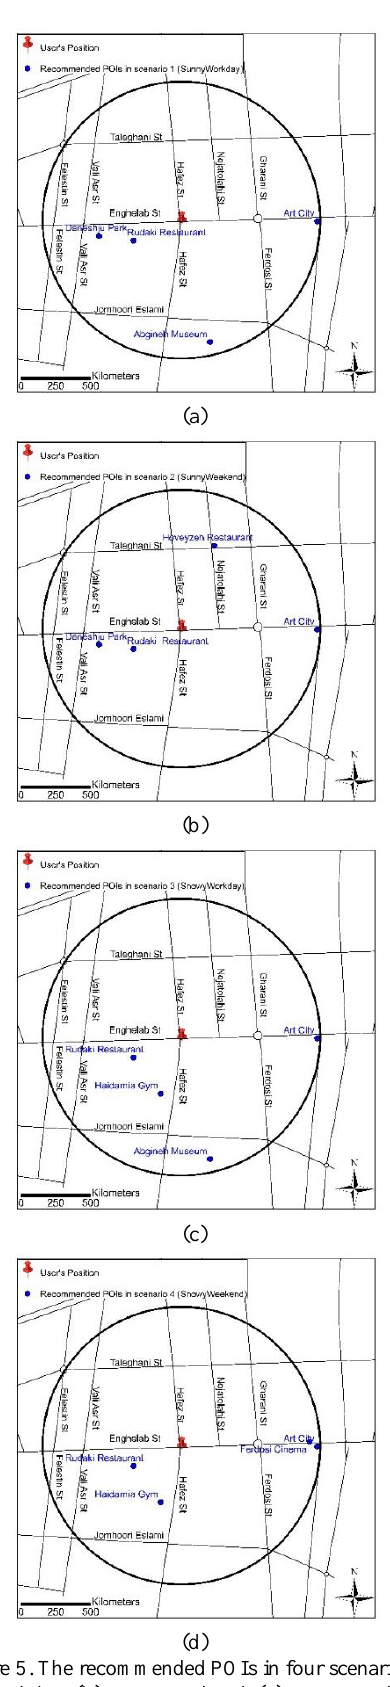
Figure 5. The recommended POIs in four scenarios (a) sunny and weekday, (b) sunny weekend, (c) snowy workday, and